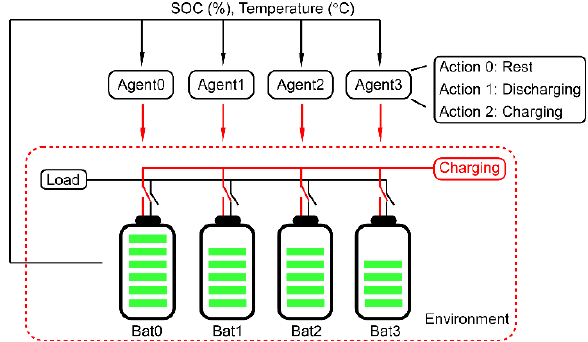
Figure 5. The architecture of the reinforcement learning battery scheduling framework. Four agents generate actions (rest, discharge, or charge) and control the four batteries. The environment measures battery state of charge (SOC) and temperatures, representing system states.